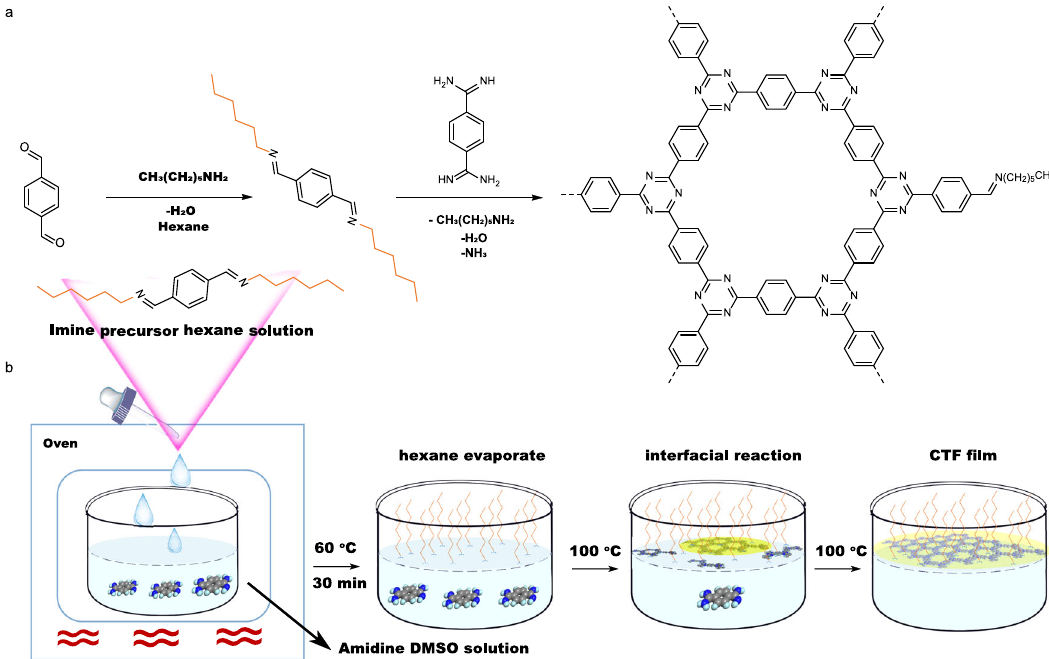
Fig. 1 Scheme of CTF fi lm synthesis. a Reaction steps. b Synthetic procedure for the fabrication of CTF fi lm on DMSO surface assisted by imine